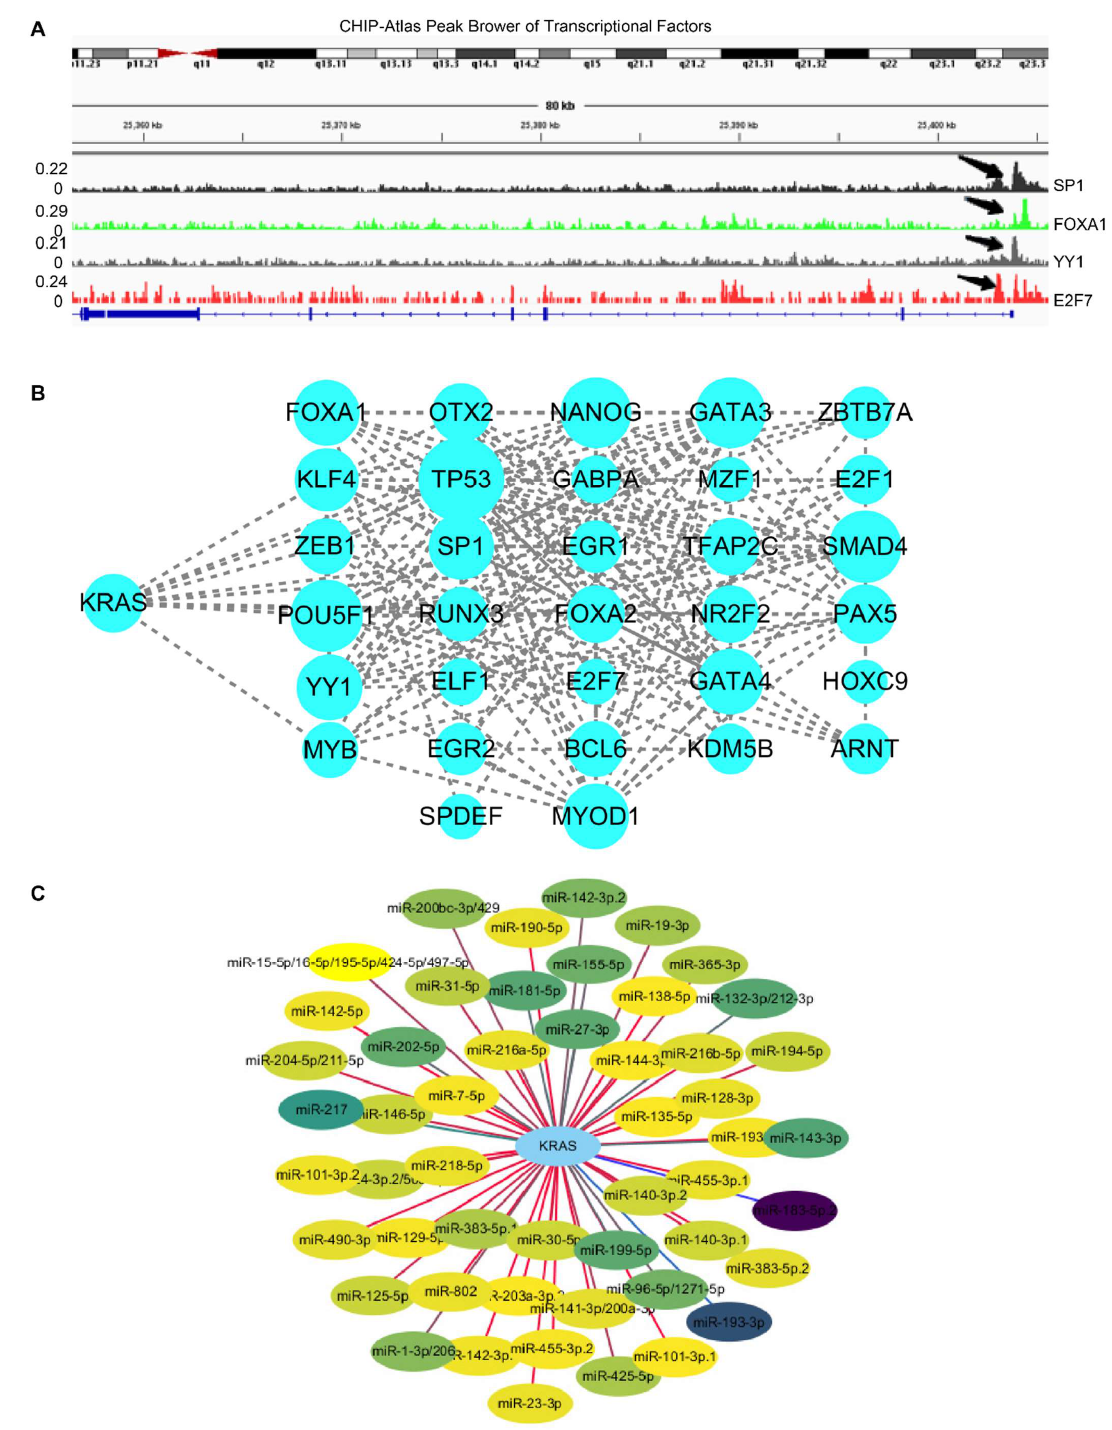
Figure 5. Regulators of KRAS. ( A ) IGV browser displaying the binding regions of transcriptional factors on the KRAS promoter regions. ( B ) PPI network showing the interaction among KRAS and transcriptional factors derived from ChIPBase V3.0. ( C ) Network indicating the interaction between KRAS and its target microRNAs derived from TargetScan